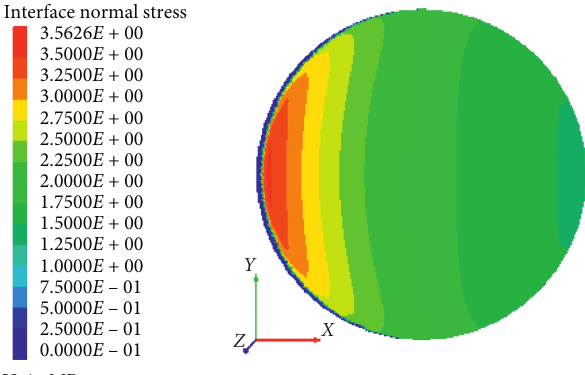
Figure 8: Normal stress distribution on the shear failure plane.